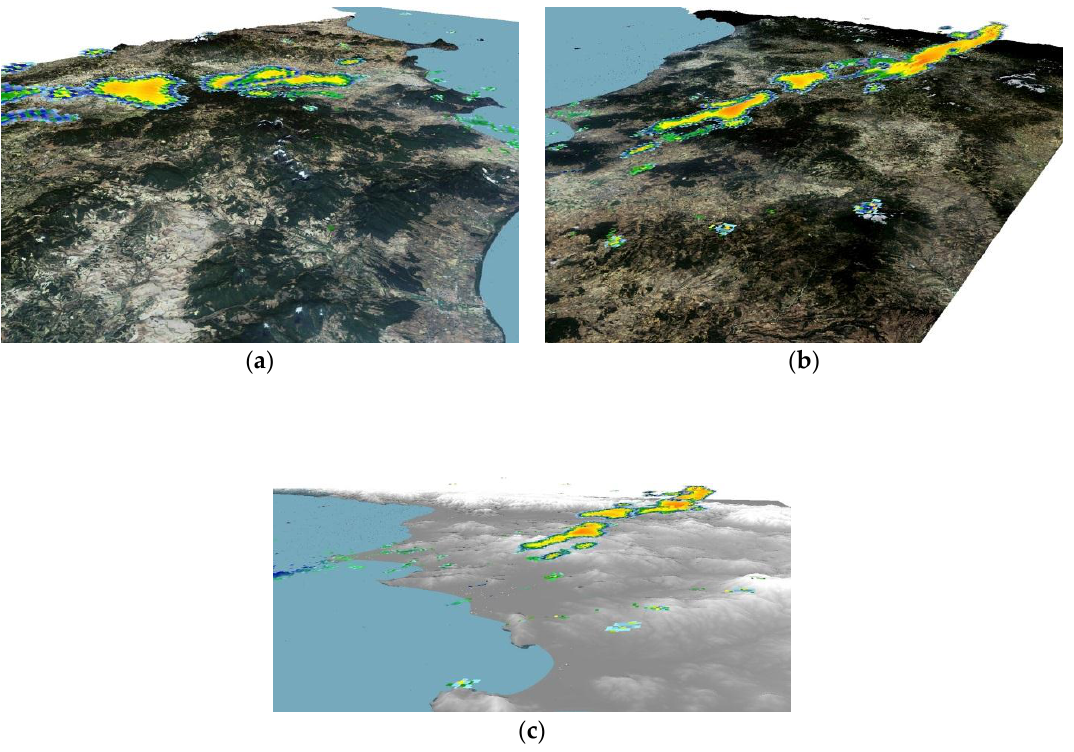
Figure 9. For the case study of 23 May 2016, 09:00 UTC, different overviews of the 3D reflectivity mosaic for an elevation of 2°, merging the radars of Livorno, Elba Island, and Castiglione della Pescaia: ( a ) northern perspective drawing, ( b ) southeastern perspective drawing, ( c ) southwestern perspective drawing.